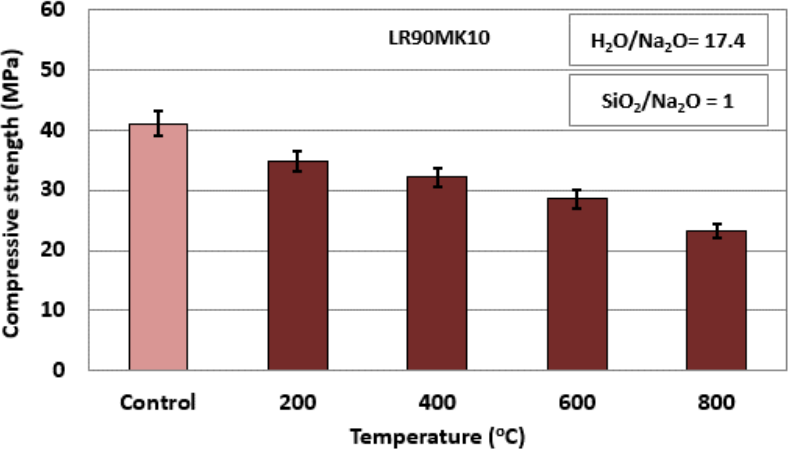
Figure 5. Evolution of the compressive strength of LR90MK10 AAMs after firing between 200 and 800 o C for 2 h (pre-curing time, 4 h; curing time, 24 h; curing temperature, 80 o C; ageing period, 7 days; error bars indicate the standard deviation of measurements obtained from three specimens.